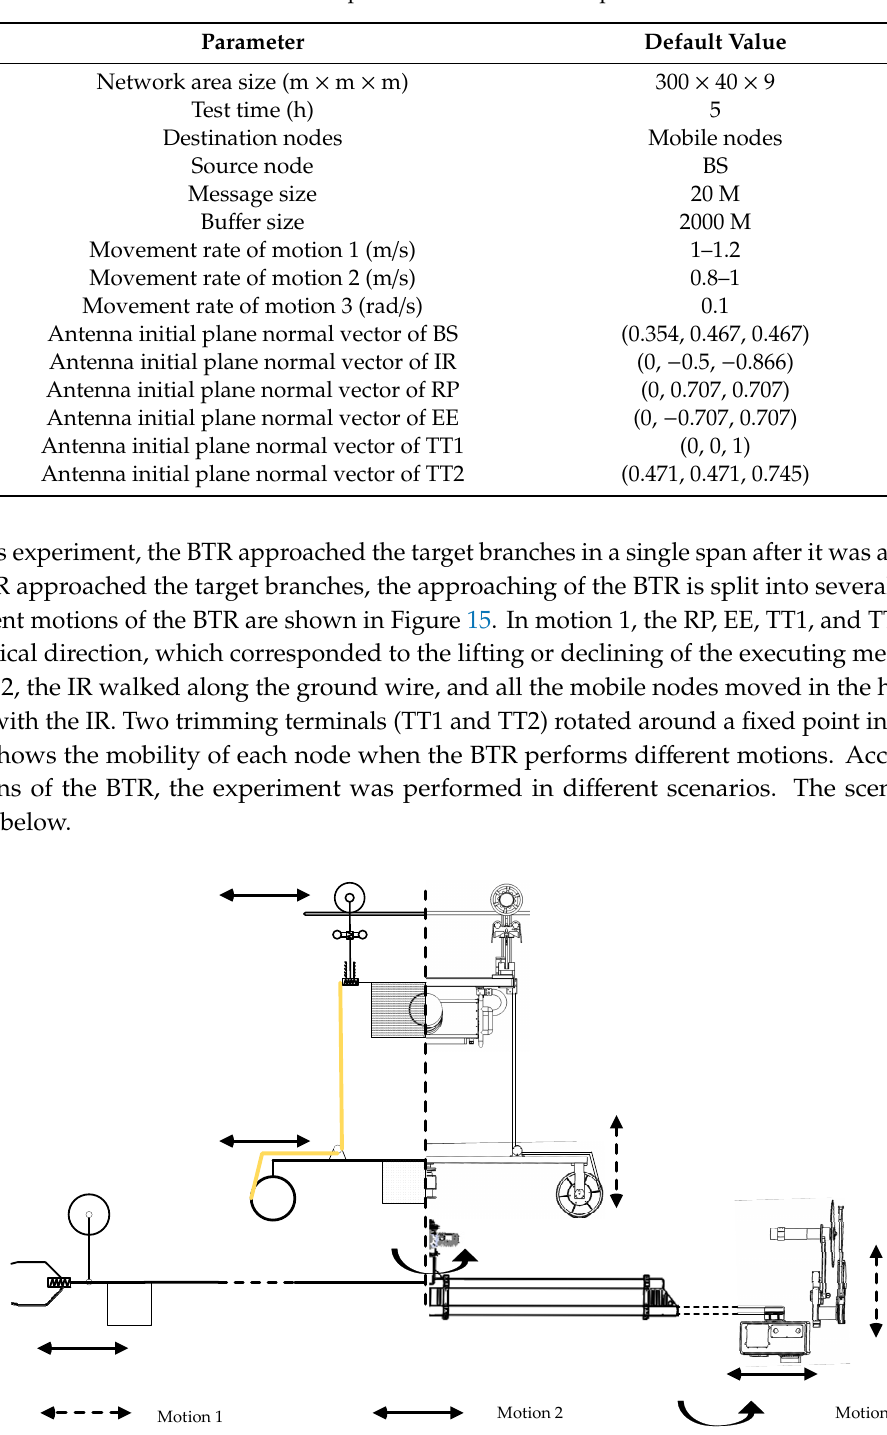
Table 5. Default parameters of the field experiment.